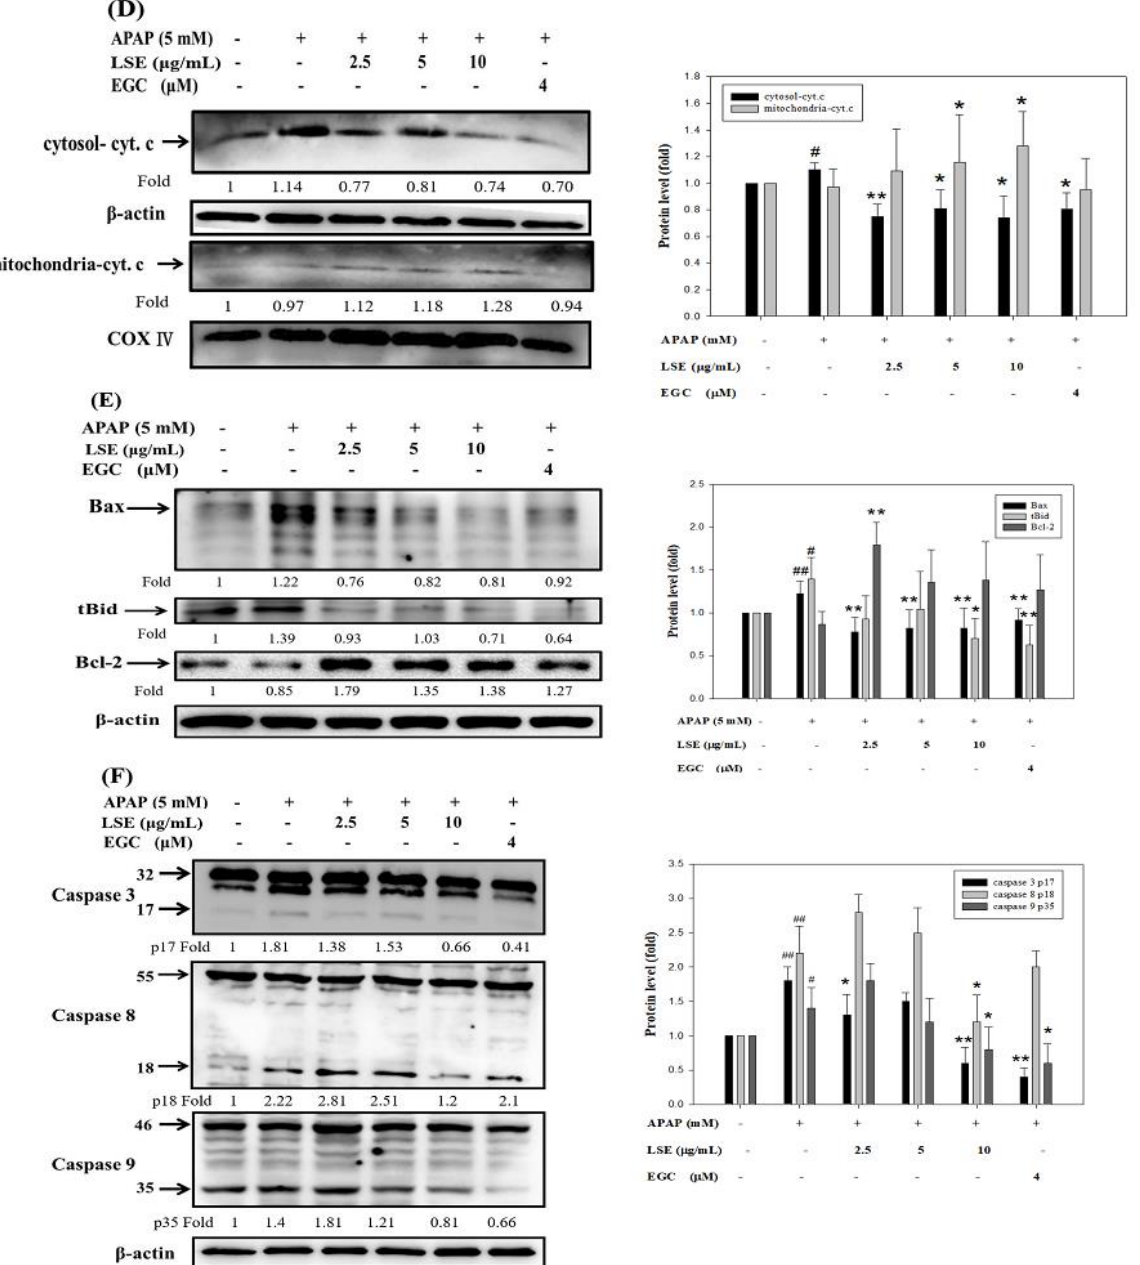
Figure 3. Effect of LSE on extrinsic and intrinsic apoptotic pathways in toxic APAP-treated HepG2 cells. HepG2 cells were treated with APAP (5 mM) in the presence or absence of LSE (2.5, 5, 10 µg/mL) or EGC (4 µM) for 24 h. ( A ) The protein levels of Fas and FasL were analyzed by Western blotting. ( B ) The protein levels of Fas and FasL were analyzed by IP. The cell extracts were IP with FasL. The precipitated complex was examined for immunoblotting (IB) using Fas antibody. ( C ) The mitochondrial membrane depolarization was assayed by JC-1staining with flow cytometry. Percentage of mitochondrial depolarization is plotted for various treatment groups. ( D ) The protein levels of cytosol and mitochondria cytochrome c were analyzed by Western blotting. ( E ) The protein levels of Bax, tBid, and Bcl-2 were analyzed by Western blotting. ( F ) The protein levels of caspase 3, 8, and 9 of each group were analyzed by W estern blotting. β -actin and COX 4 were served as an internal control of cell cytosol and mitochondria. All data were presented as means ± SD of three independent experiments. # p < 0.05, ## p < 0.01 compared with the control group. * p < 0.05, ** p < 0.01 compared with the APAP group.